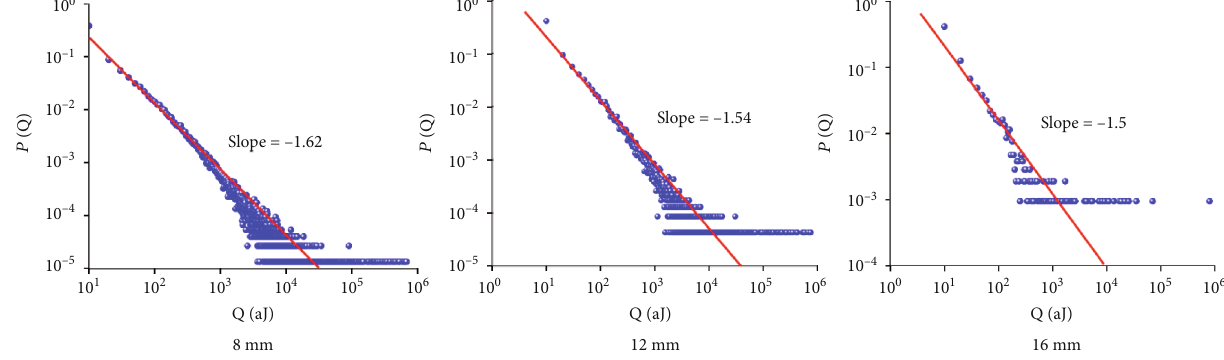
Figure 7: Acoustic emission energy probability density diagram of the specimen with drilled hole.